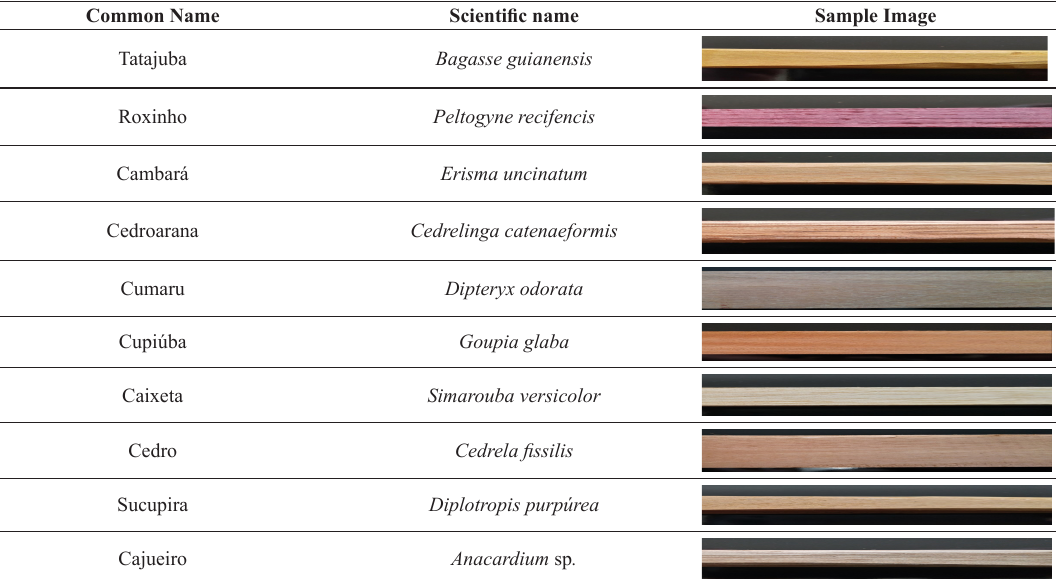
Table 1. Ten wood species and its illustrative